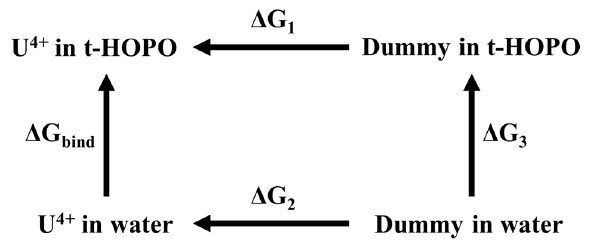
Figure 12. ( a ) Atomic positional RMSD of all atoms of U IV ( κ 8 - t -HOPO) complex with the central structure of cluster 1 used as the reference. ( b ) The superposition of the central structures of the top three clusters (colored in red, green and blue according to their ranks) in the simulations of U IV ( κ 8 - t -HOPO) complex. The cutoff for clustering analysis is 0.05 nm. ( c ) The central structures of the top three clusters in the simulations of U IV ( κ 8 - t -HOPO) complex. Color scheme: N atoms in blue, O at- oms in red, water molecules in black, C atoms in cyan, H atoms in white, and U atom in brown. The time evolution of RMSD with the starting structure as the reference was also calculated and is pro- vided in the Supporting Information (Figure S6).